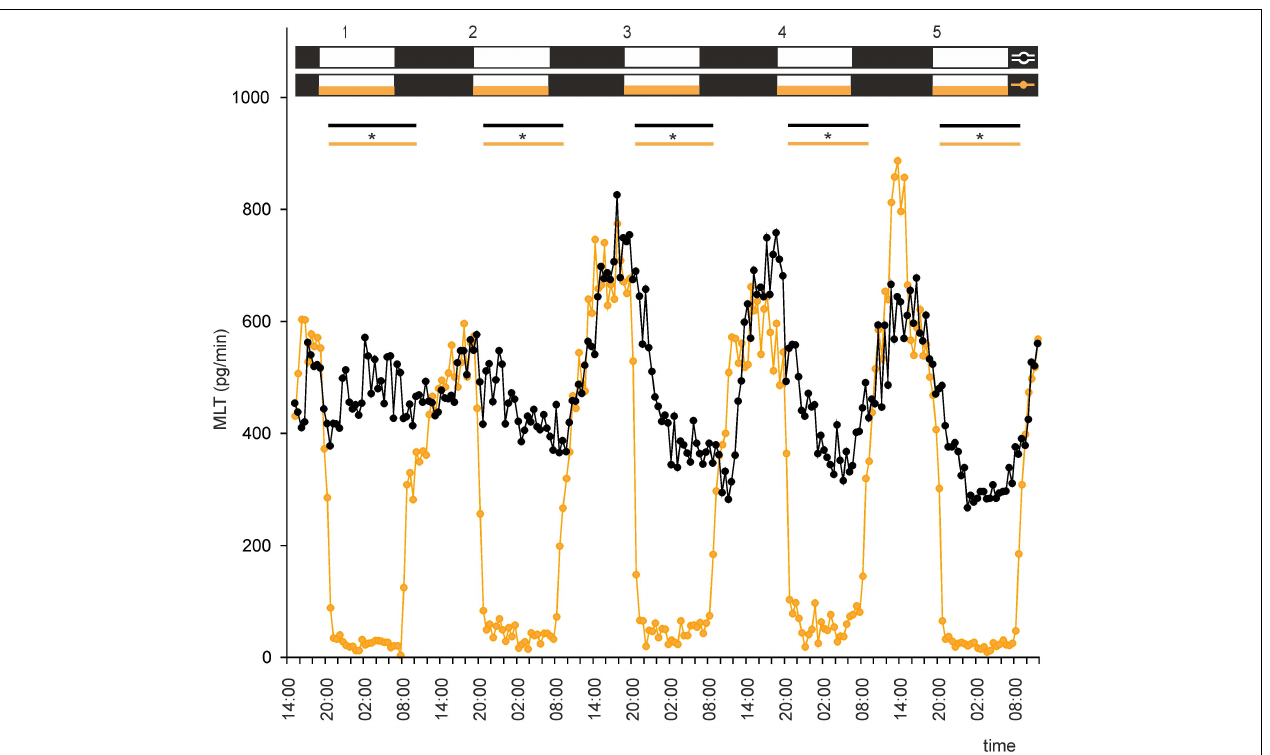
FIGURE 3 | Secretion (means, n = 4) of MLT by goose pineal organs incubated under reversed dark-light cycle (DL) for 5 days with the presence of NE during photophase (orange line with circles) and without it (black line with circles). White horizontal bars in upper part of image indicate photophase; black bars indicate scotophase; orange bars indicate period of NE treatment. Parallel lines with asterisks show periods, when the means differ significantly ( p < 0.05) between